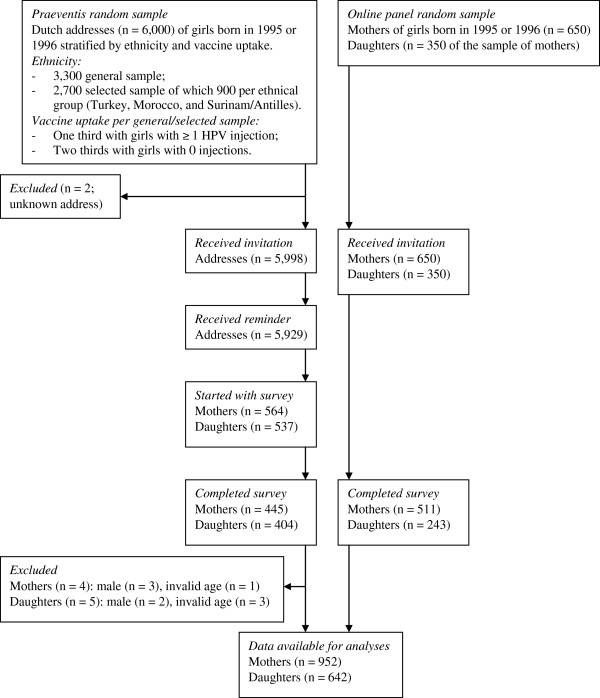
Flow diagram of the recruitment and response of study participants.